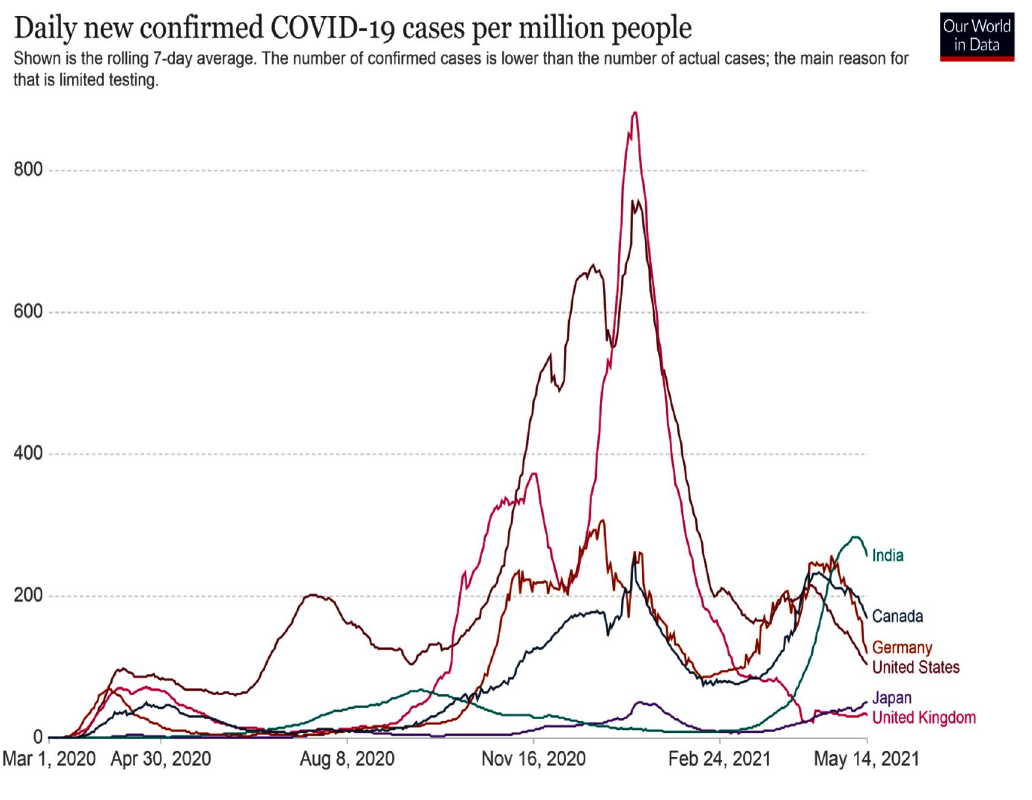
Fig. 1. Confirmed COVID-19 cases globally as on May 14, 2021 6